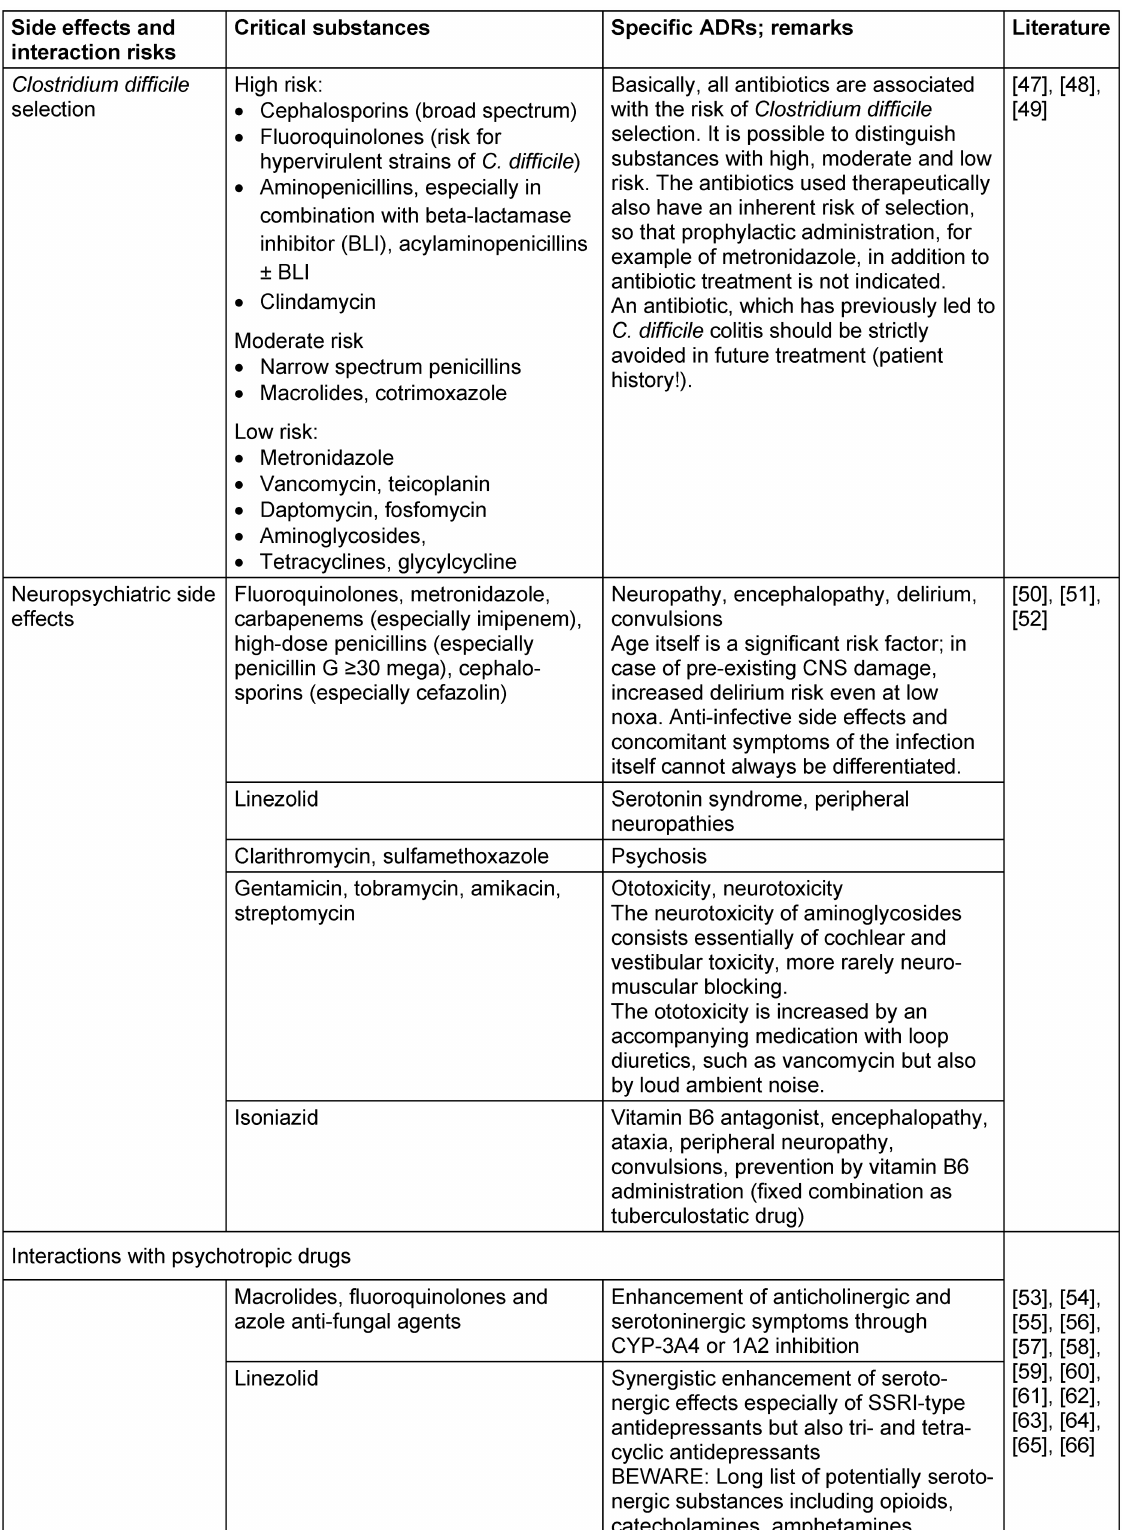
Table 3: Evaluation of the individual antibiotic classes or individual substances according to side effects and risk of